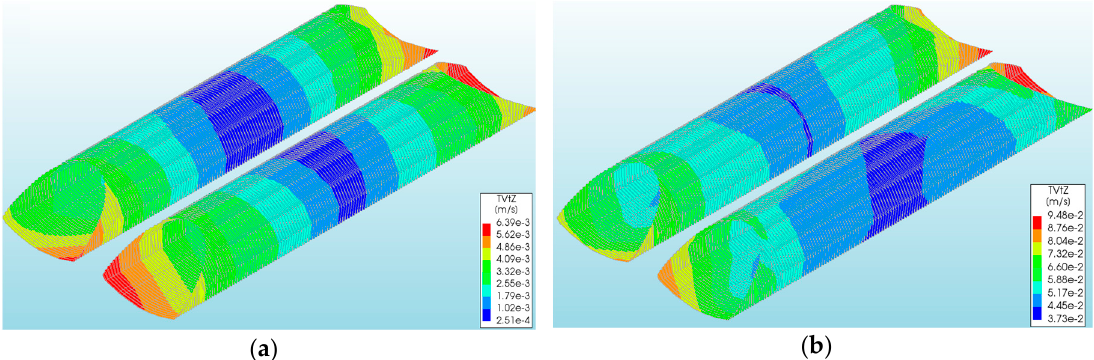
Figure 12. Maximal values of vibration velocity of: ( a ) Rockburst for model Va, ( b ) El Centro for model IVb.